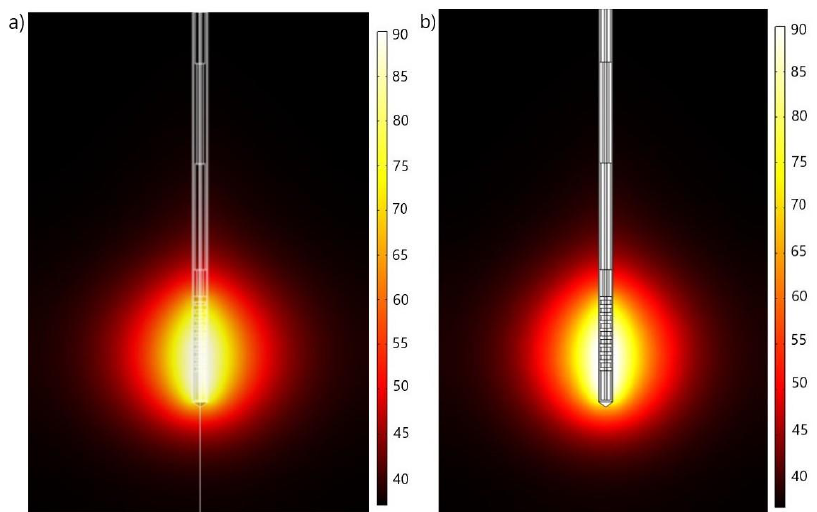
Figure 5. Results of ( a ) two-dimensional axial-symmetric and ( b ) full three-dimensional simulation models of the temperature (expressed in °C) distributions in the liver tissue after 600 s of microwave ablation at a frequency 2.45 GHz and the input power of 10 W.